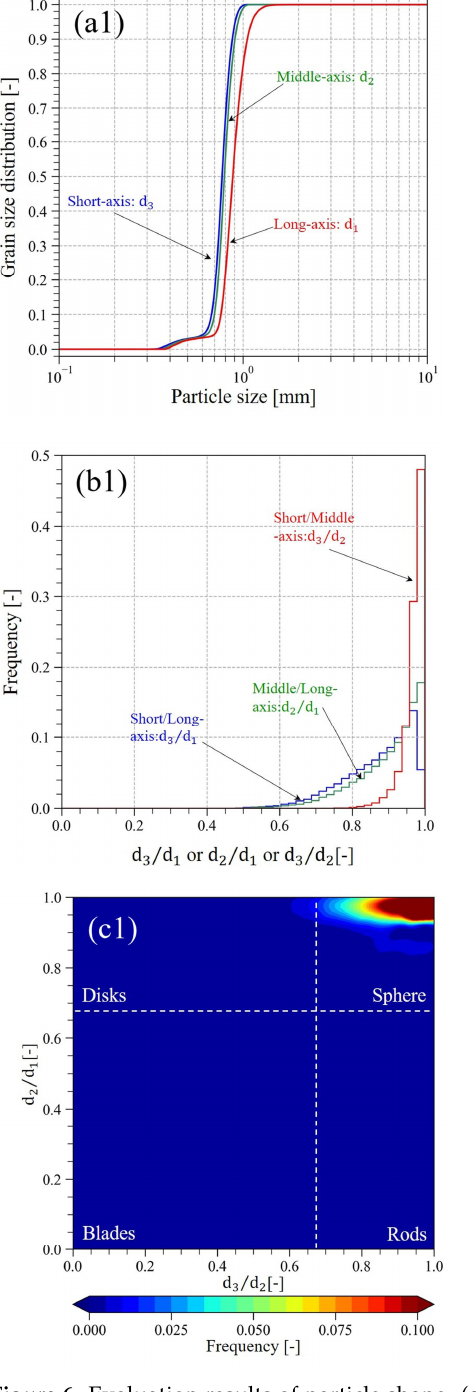
Figure 6. Evaluation results of particle shape. ( a1 , a2 ) are the cumulative ratio curve of d 1 , d 2 , d 3 , and d m (only for KS). ( b1 , b2 ) are the histograms of d 3 /d 1 , d 2 /d 1 , d 3 /d 2 , and e w /e l (only for KS). ( c1 , c2 ) are Zingg diagrams. The left columns are evaluation results of the GBs, and the right columns for KS. GBs, glass beads; KS, Kashima–Keisa natural sand.